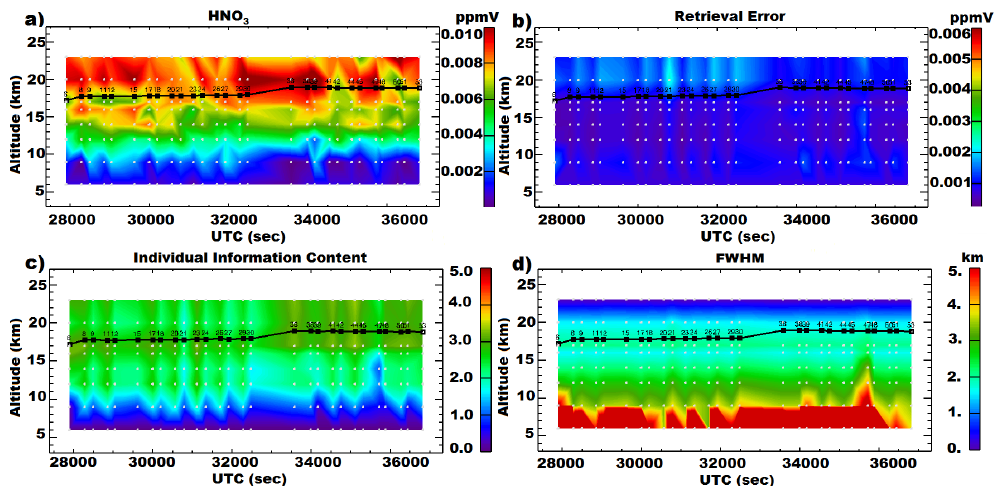
Fig. 10. As in Fig. 5 but for HNO 3 retrieved from band C and